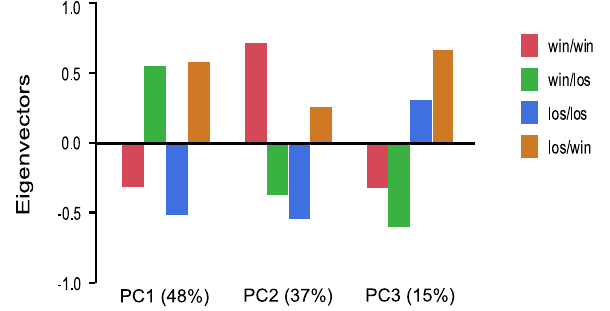
Figure 5. Analysis of global gene expression in pleometrotic queens after manipulation of social rank. Principal Component Analysis of 606 significantly differentially regulated transcripts revealed three principal effects corresponding to switch of the social rank (48%), final rank (37%) and initial rank (15%). win/los=winners switched to losers; win/win=continuing winners; los/win=losers switched to winners; los/los=continuing losers.